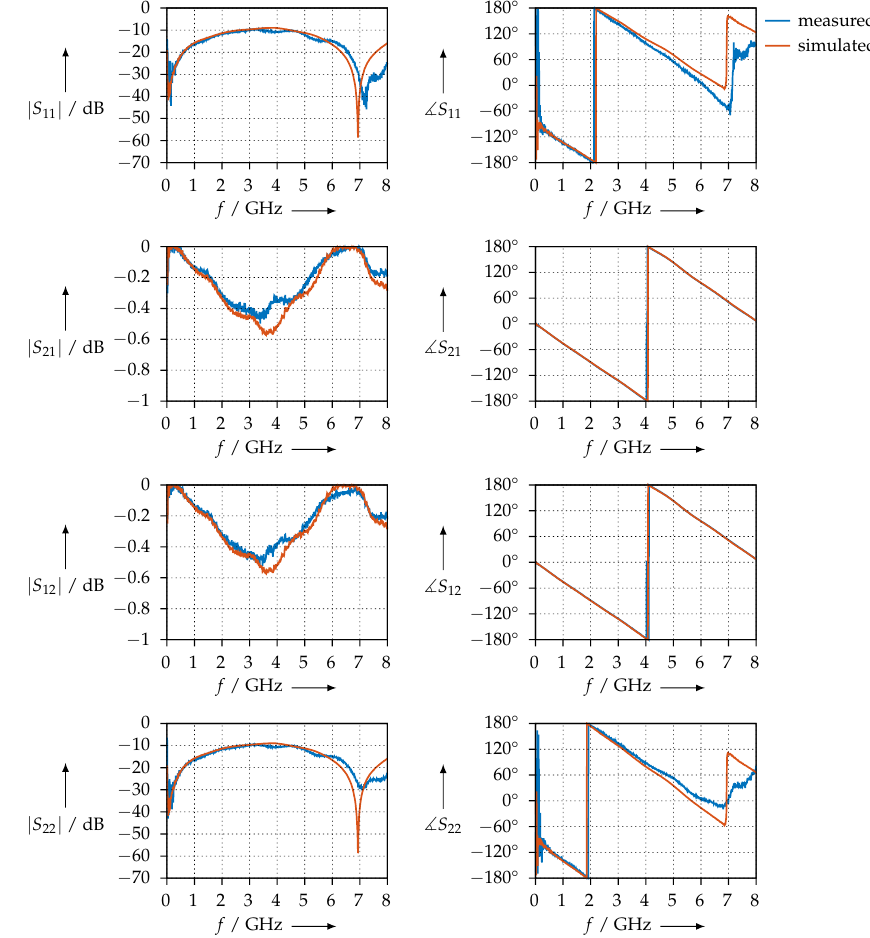
Figure 11. Measured and simulated S-parameters of the PTFE sample in the coaxial transmission